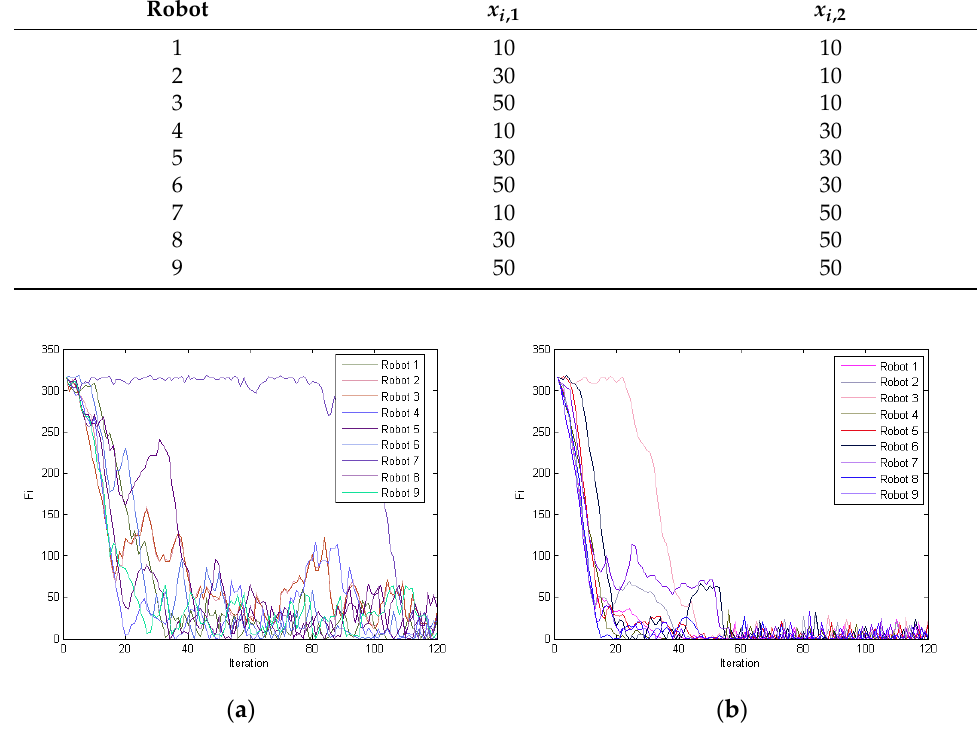
Figure 15. The F i evolution of each robot for aggregation in noise free environment: ( a ) The controller in Reference [27]; ( b ) BCCS.